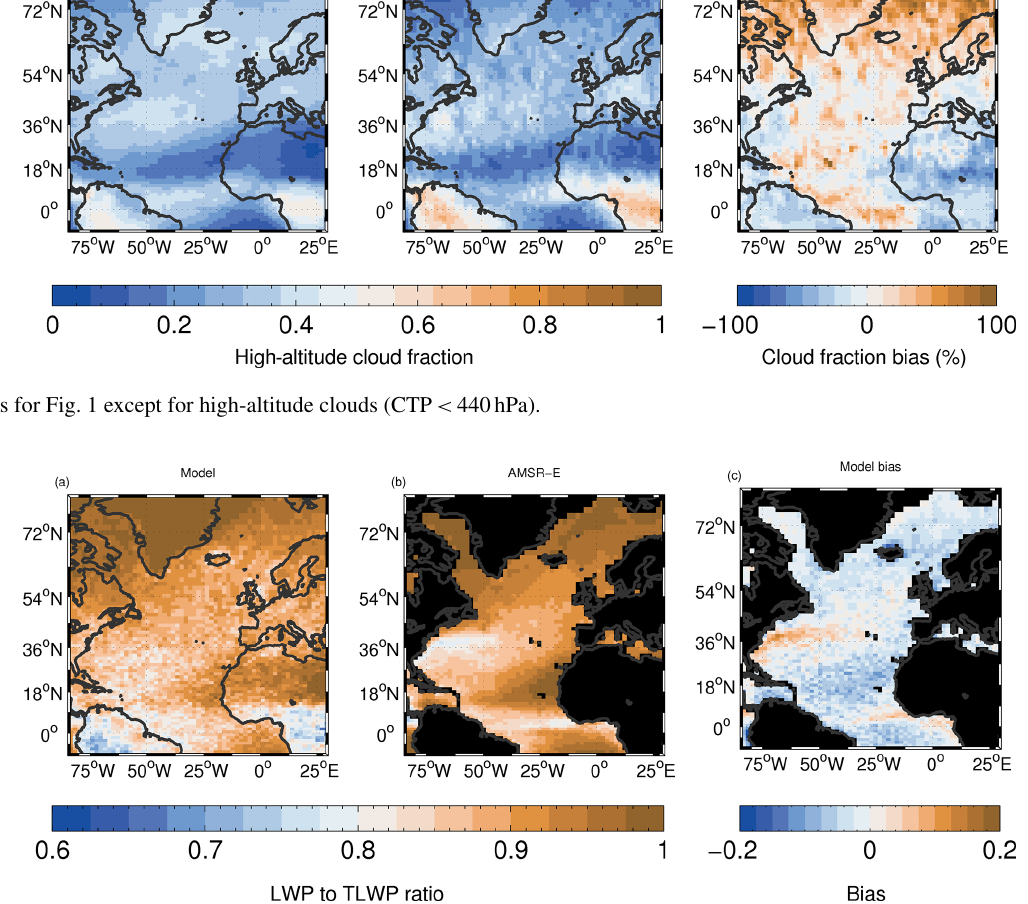
Figure 4. Time average of f LWP (ratio of LWP to the sum of LWP and RWP). For the model, LWP and RWP contributions from both the large-scale cloud scheme and the convective parameterization are included. The RWP for AMSR-E is calculated from the retrieved LWP and rain rate by inverting the retrieval algorithm, as described in Elsaesser et al. (2017). The same raindrop size distribution and fall speed relationship as for the model is used. Both daytime and nighttime AMSR-E overpasses are